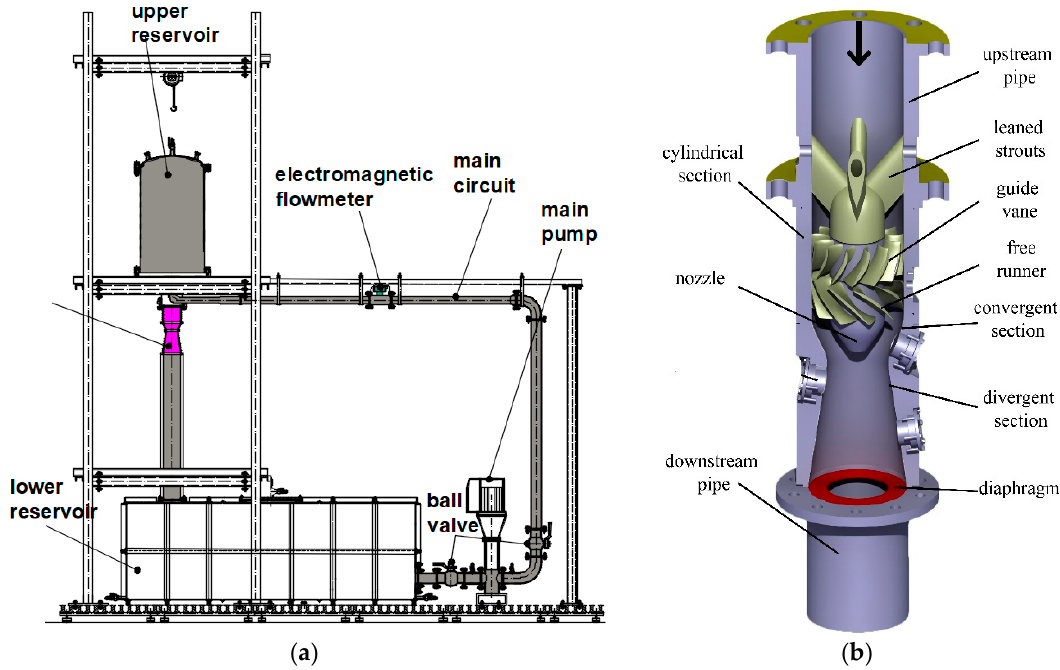
Figure 2. Sketch of the test rig with the main elements of the hydraulic circuit ( a ). Detail of the test section and swirl generator ( b ).